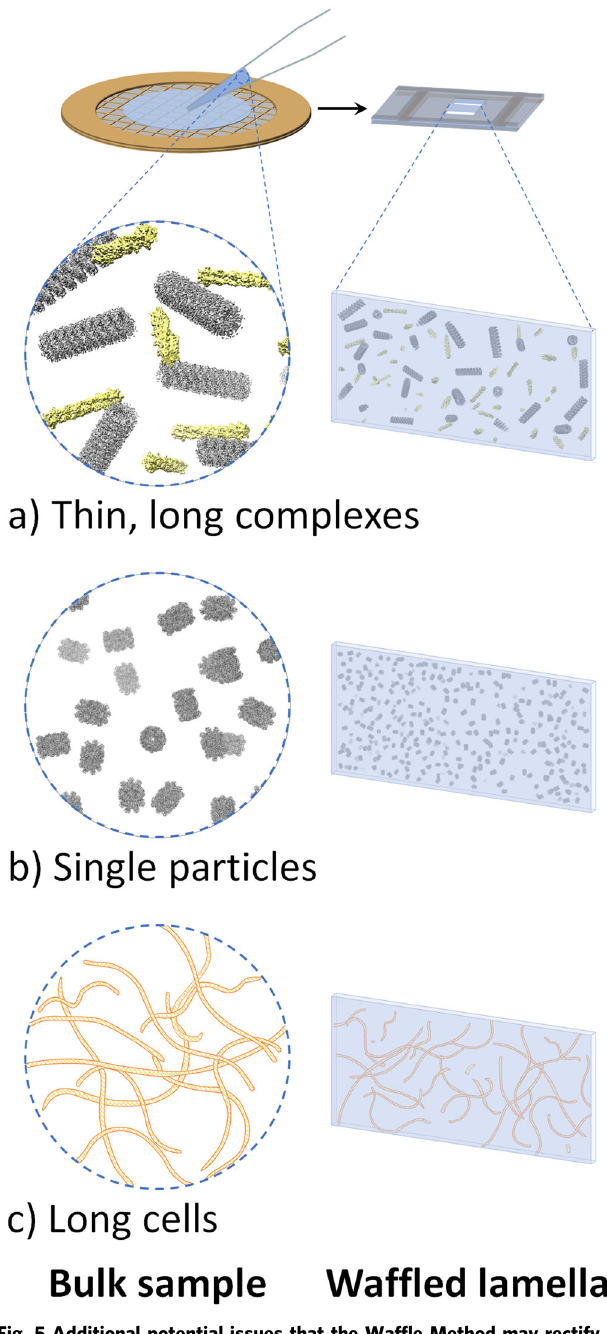
Fig. 5 Additional potential issues that the Waf fl e Method may